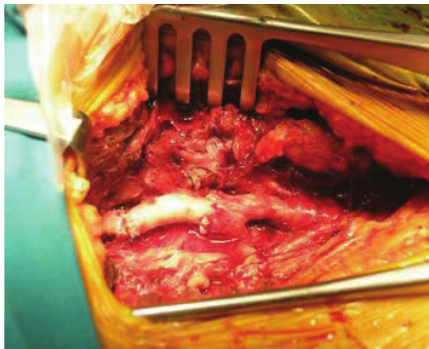
Figure 5: Reconstruction of common femoral artery by autoarterial graft interposition (previously prepared iliac artery).